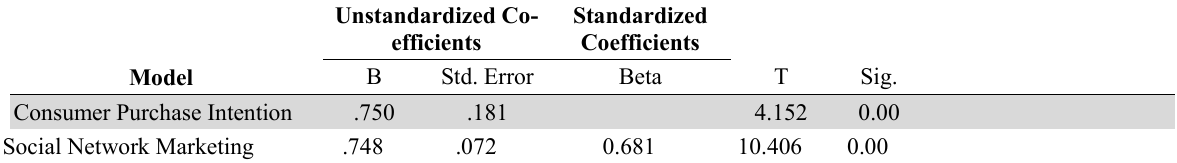
Regression Analysis of Social Network Marketing on Consumer Purchase Intention Unstandardized Co- Standardized efficients Coefficients T Sig. B Std. Error Beta Model Consumer Purchase Intention .750 .181 Social Network Marketing